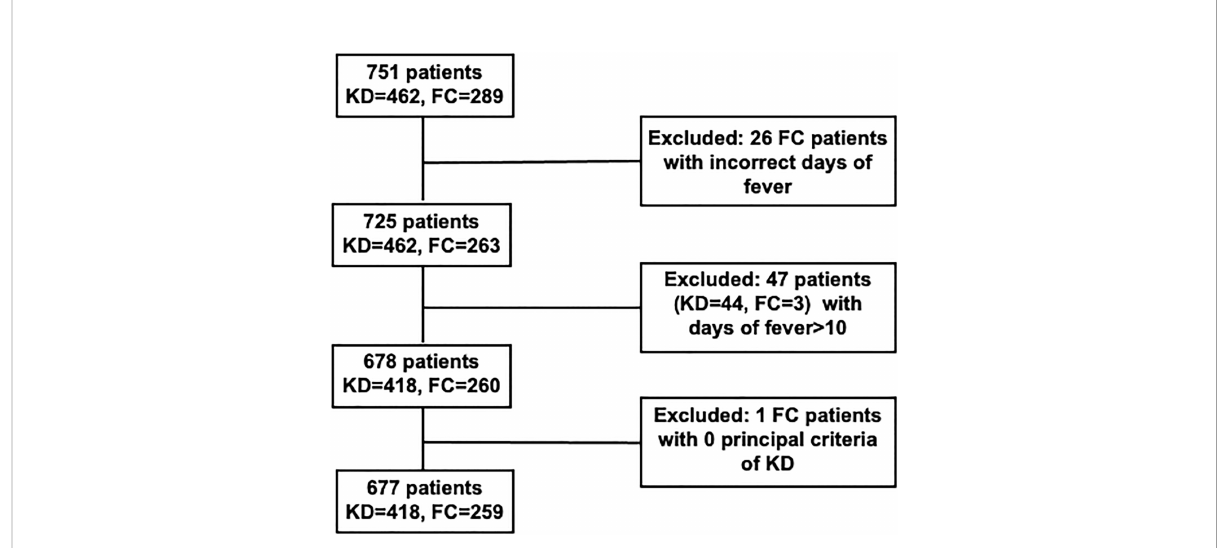
TABLE 1 Distribution of the clinical signs among KD and FC patients (count and percentage) in sub cohorts manifesting fewer than 2, 3 or ≥ 4 principal clinical criteria for KD.